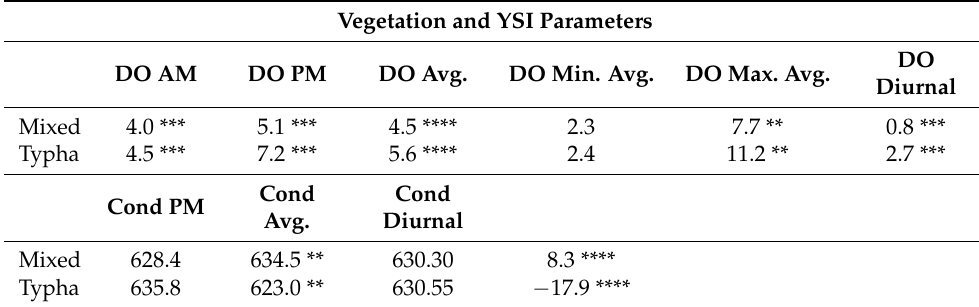
Table 2. Significant differences between YSI parameters by mesocosm vegetation type. Vegetation and YSI Parameters